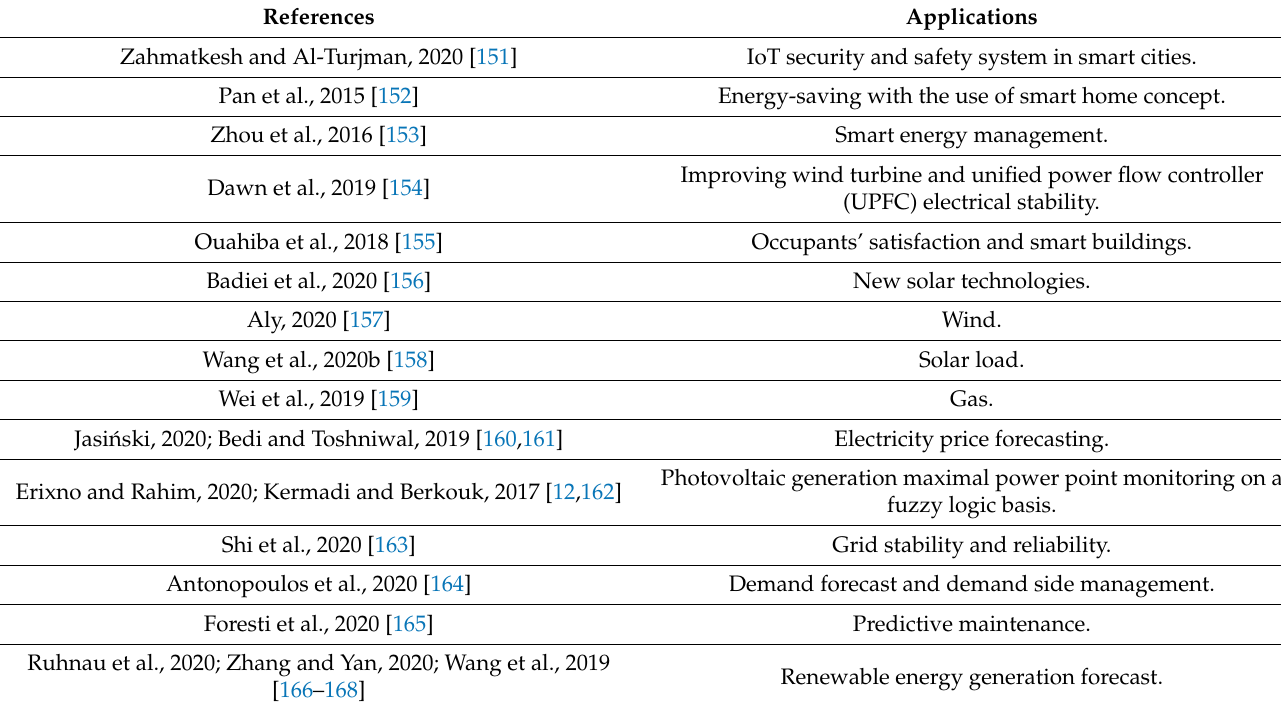
Table 2. Application of artificial intelligence in various power